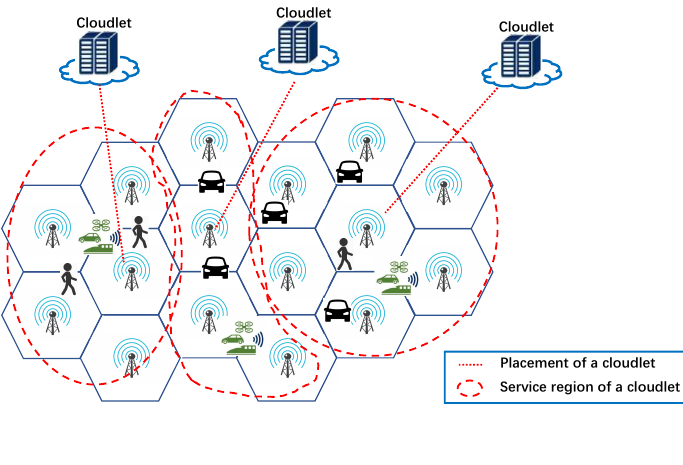
Figure 1. When deploying the cloudlets, their location, capacity and service region should be properly